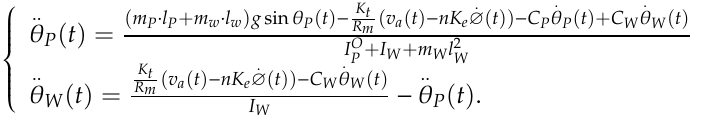
Table 1. System parameters.